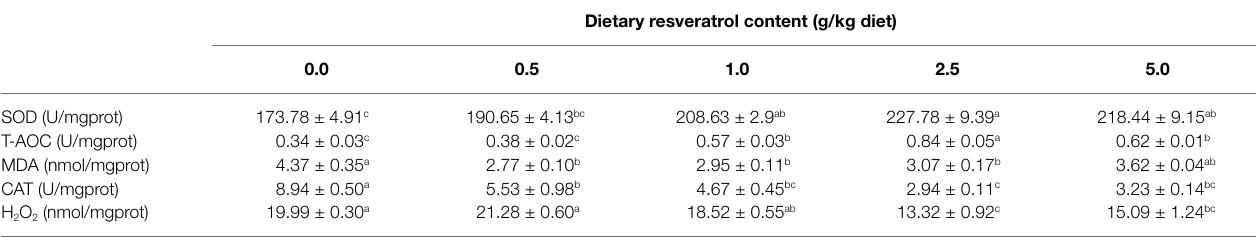
TABLE 3 | Antioxidant indexes of of largemouth bass fed diets with varying dietary RSV levels for 10 weeks * .